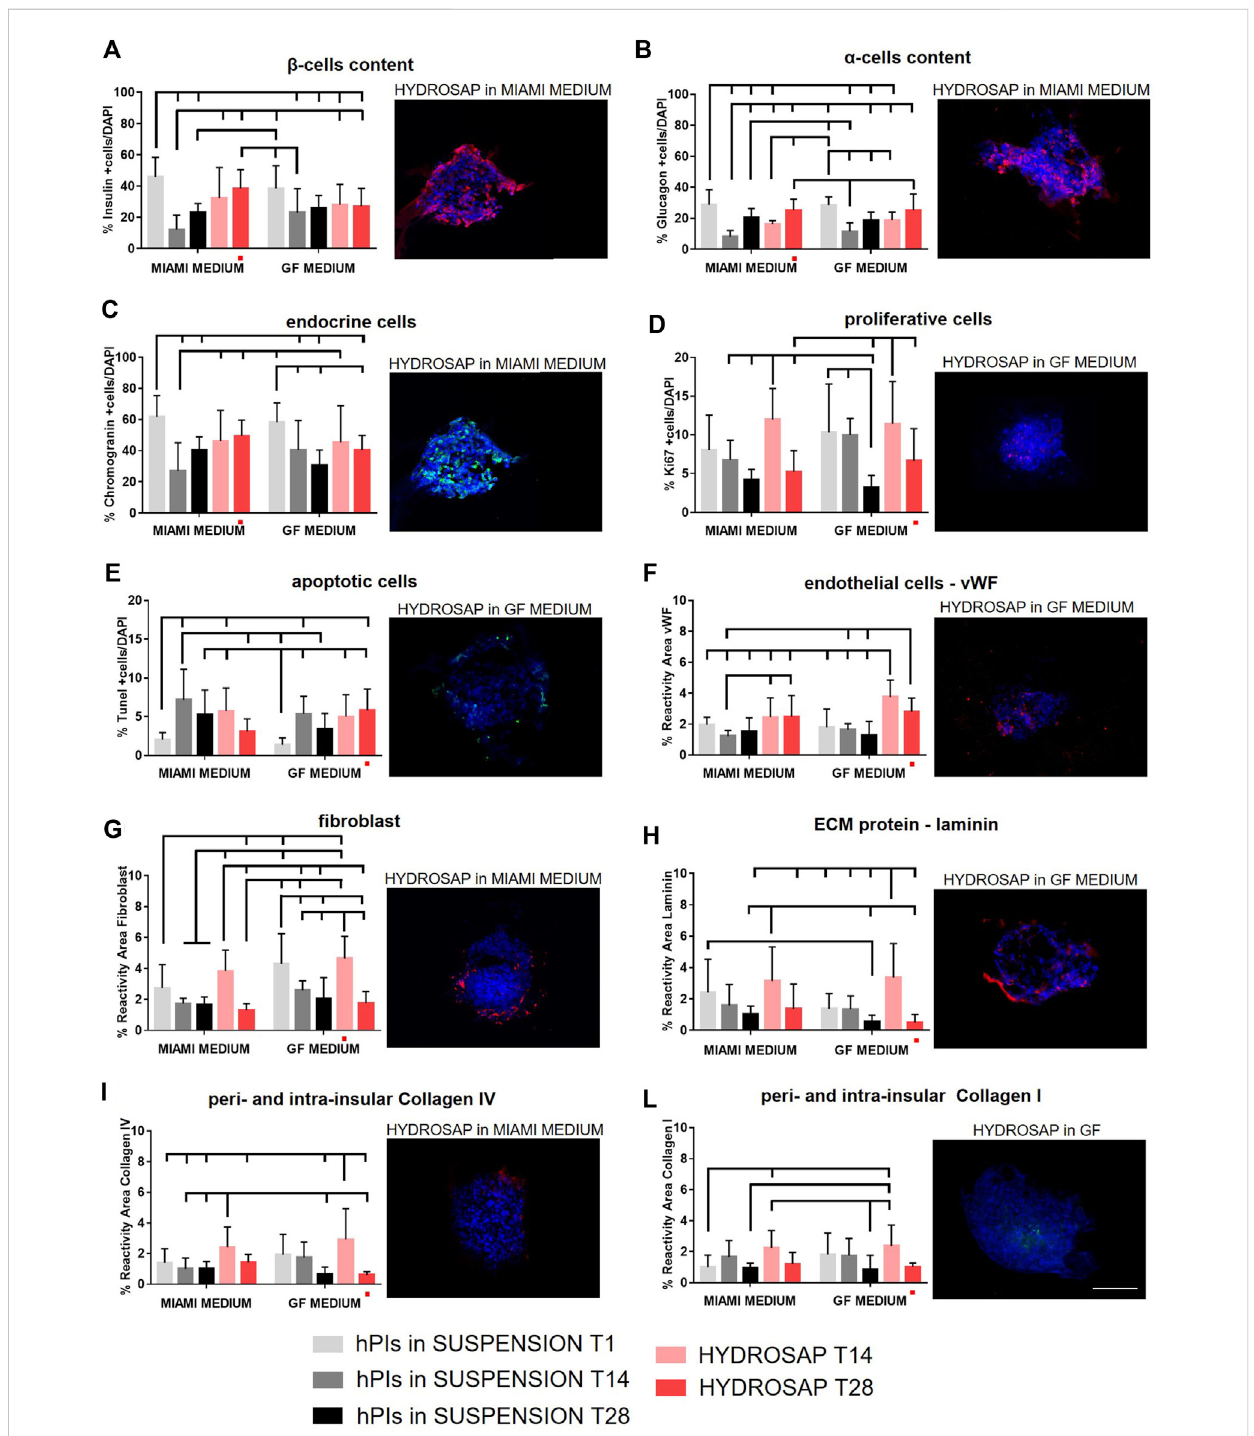
FIGURE 4 Long-termtime-trackingofhPIsinsuspensionorencapsulatedinHYDROSAPhydrogel.Isletswereculturedfor1 day(T1),14 days(T14)and28days (T28) and fed with MIAMI or GF media. Graphs and related images represent the percentage of positive cells for (A) insulin (red), (B) glucagon (red), (C) endocrine cells (green), (D) proliferative cells (red), displaying steady values (28-days) especially for hPIs cultured in MIAMI medium, with a stable percentage of apoptotic cells ( E , in green) over time. In long-term cultures, also the percentage of reactivity area for (F) endothelial cells in red, (G) fi broblast inred, (H) laminin inred, (I) collagenIVinredand ( L )collagenIingreenwereevaluated: vWFand collagenI remained stable inHYDROSAP with both MIAMI and GF media, while fi broblast, laminin, and collagen IV decreased drastically at 28-days in HYDROSAP with GF media, while it stabilized in HYDROSAP with MIAMI medium. Cell nuclei are stained in blue. Images illustrate islets in selected culture conditions, depicted in each graph with a red dot. Data are presented as mean ± SD, two-way ANOVA with Tukey post-hoc test: statistical differences were evaluated among all groups at different timepoints and speci fi ed in Supplementary Table S4 ( n = 3; * p < 0.05 ; ** p < 0.01 ; *** p < 0.001 ). Scale bar, 100